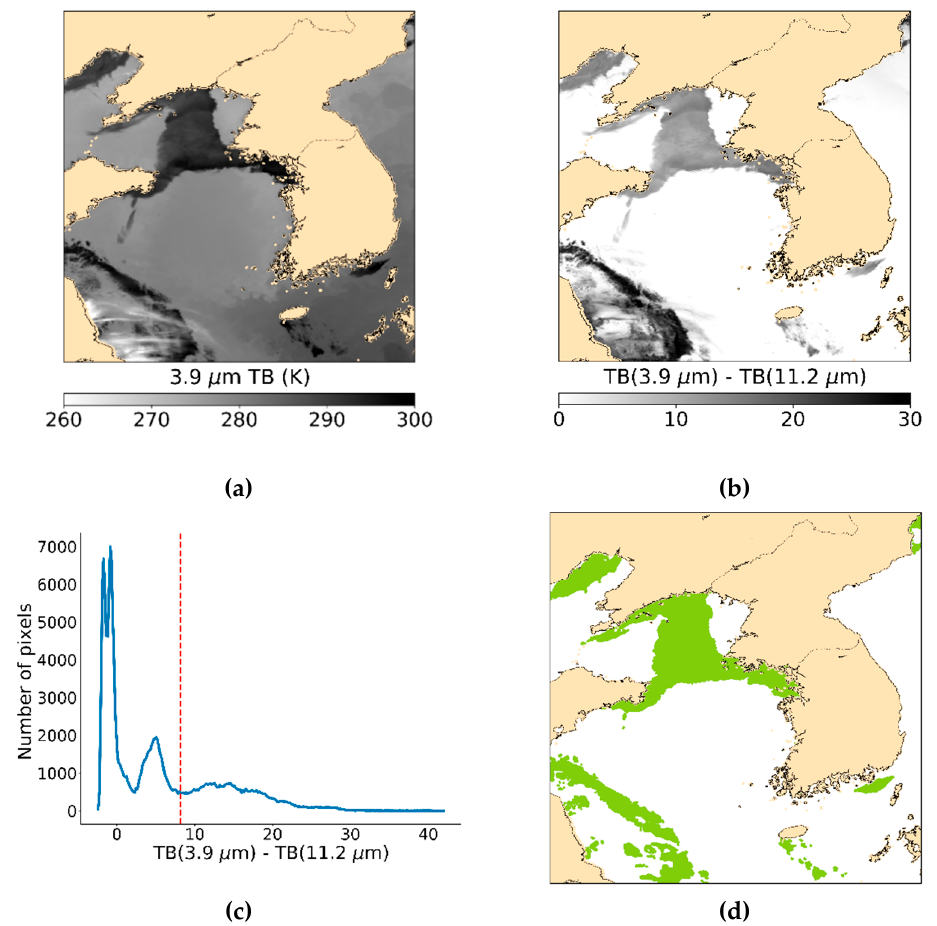
Figure 5. Examples of ( a ) brightness temperature (TB) at AHI 3.9 μ m and ( b ) brightness temperature differences (BTD) between AHI 3.9 μ m and AHI 11.2 μ m, ( c ) histogram of BTD and threshold value determined using the Otsu method, and ( d ) the sea fog area after applying the threshold value.